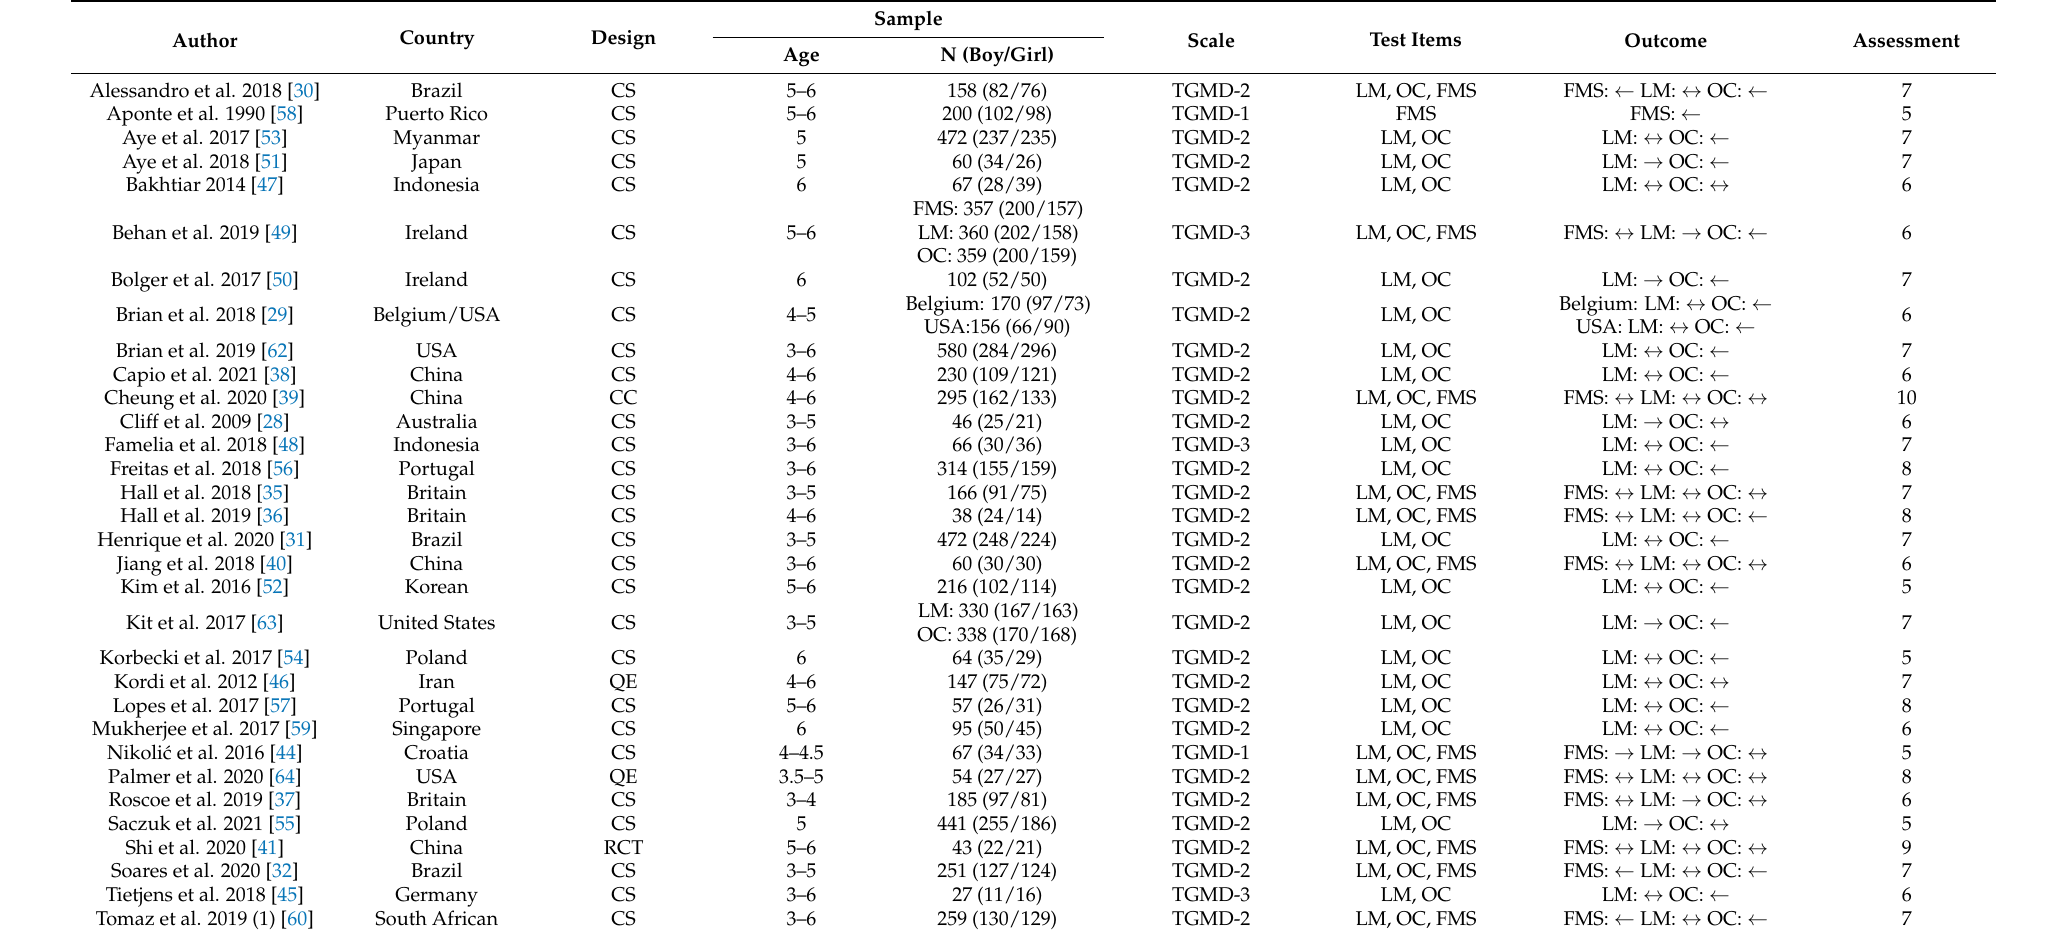
Table 1. Characteristics of the included